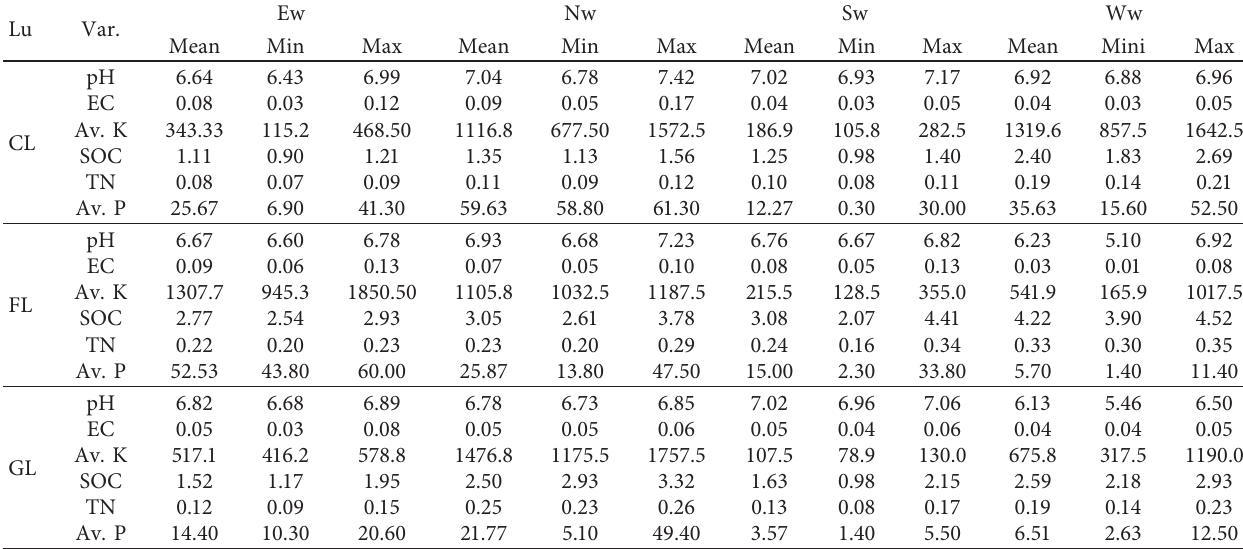
Table 1: Descriptive statistics of selected soil properties across slope aspects and land use